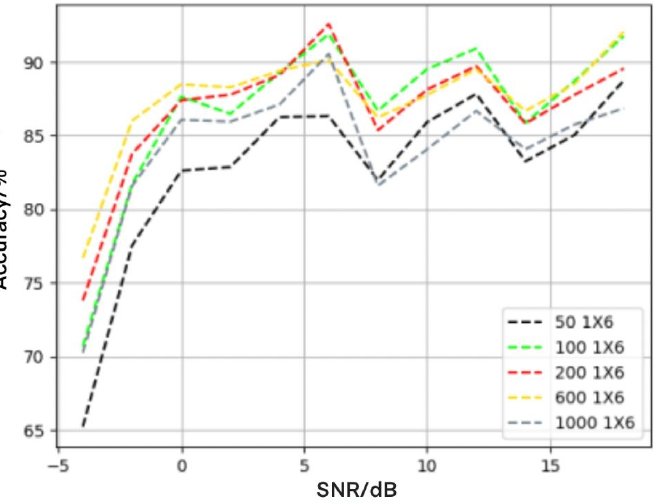
Figure 4. Effect of different convolution kernels on recognition rate (size 1 ×